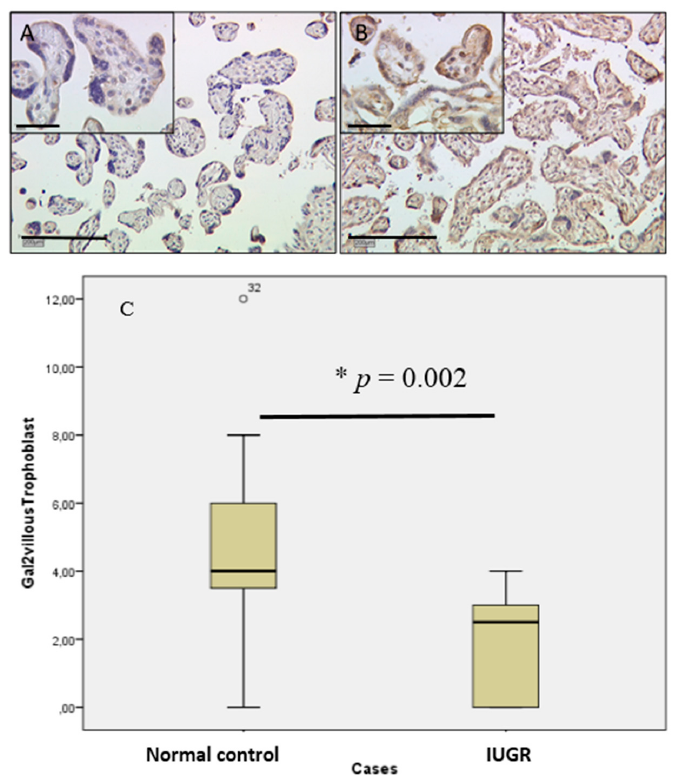
Figure 2. Gal-2 staining in cases of IUGR in villous trophoblasts ( A ) compared to control placentas ( B ) [20] appeared to be downregulated. The noted differences in staining intensity are statistically significant (* p = 0.002), as shown in the box-plot ( C ). The range between the 25th and 75th percentiles is represented by the boxes with a horizontal line at the median. The bars show the fifth and 95th percentiles. The circle indicates values more than 1.5 box lengths.